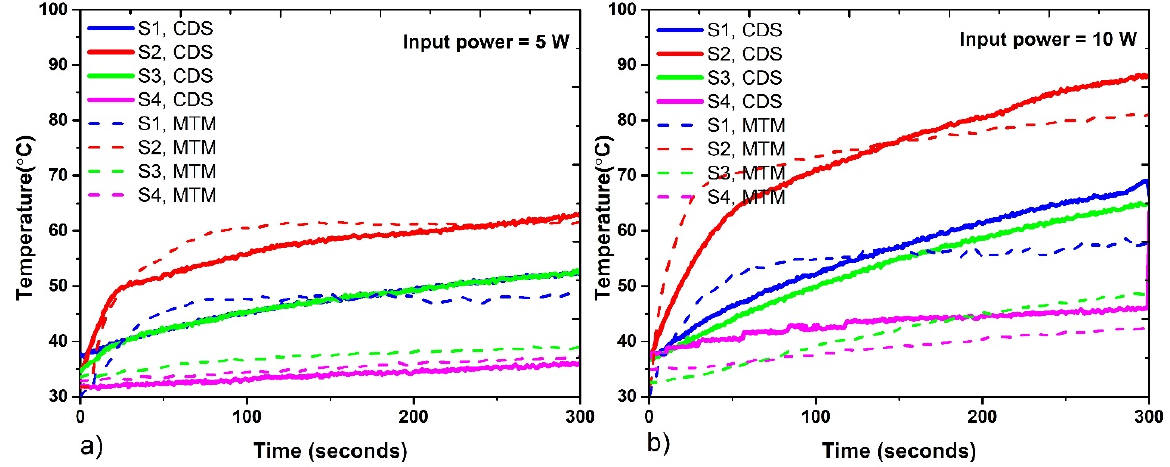
Figure 9. Temperatures reached by each antenna during the experiments in porcine ex vivo tissue. ( a ) Temperature profiles reached with 5 W, ( b ) Temperature profiles reached with 10 W.